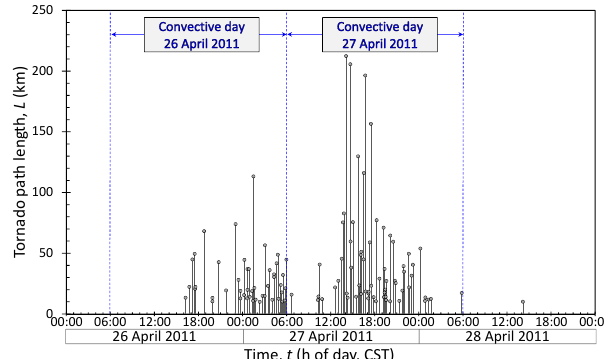
Figure 2. Tornado outbreak on 26–28 April 2011. Times of touch- down and path lengths of severe tornadoes ( L ≥ 10km) that oc- curred on 26, 27 and 28 April 2011. There were 45 severe tornadoes on 26 April (convective day, 06:00CST to 06:00CST the following day) and 64 severe tornadoes on 27 April (convective day). Data were obtained from NOAA